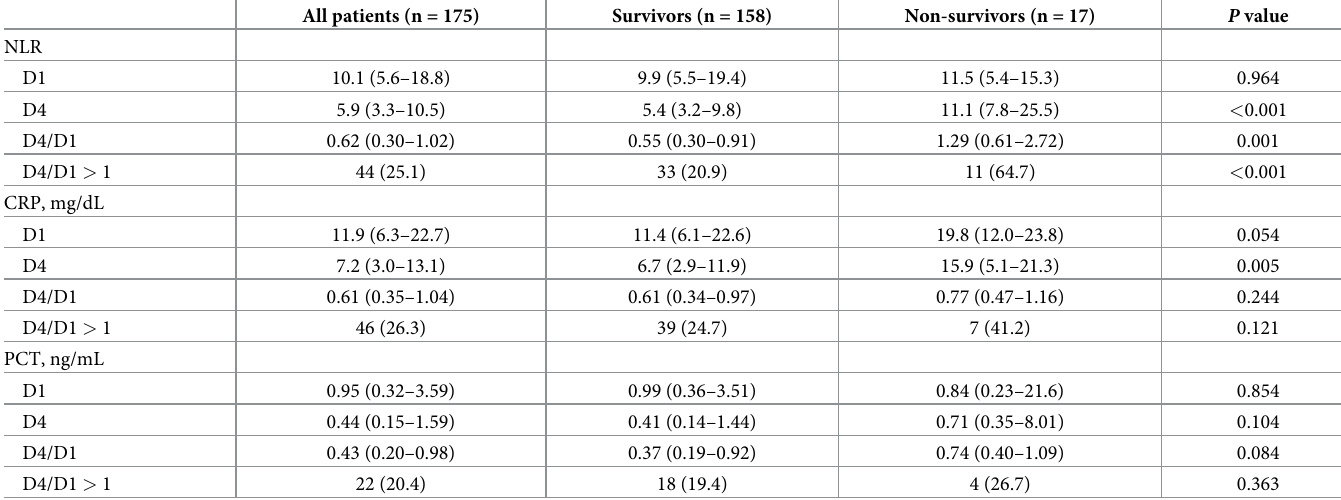
Table 2. Systemic inflammatory biomarkers in survivors and non-survivors.